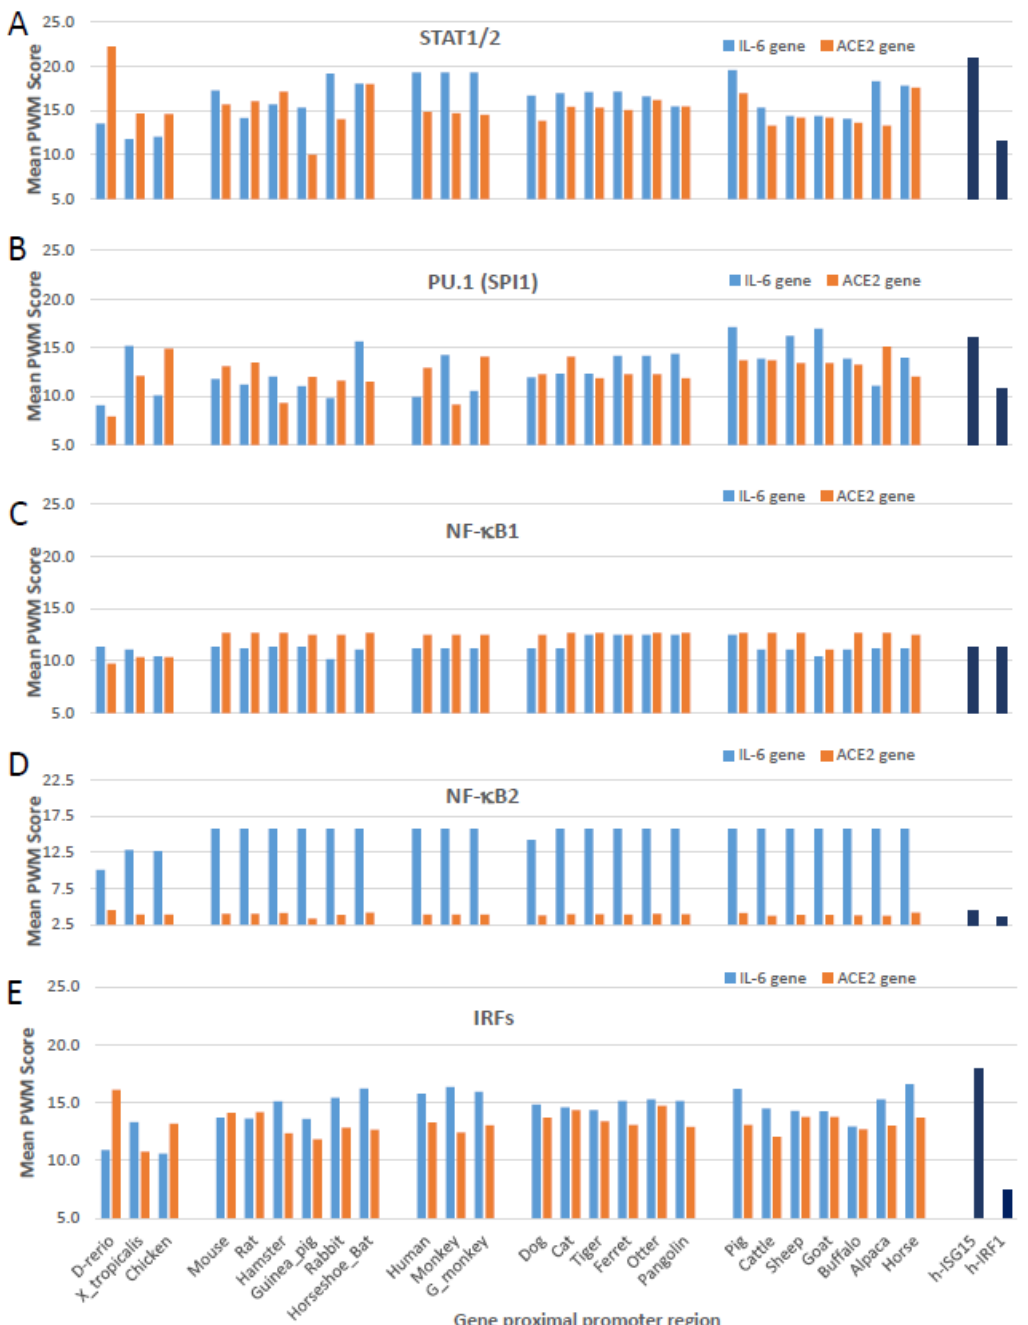
Figure 5. Cross-species analysis of mean PWM scores of cis -regulatory elements (CREs) that bind ( A ) STAT1/2, ( B ) PU.1 (a.k.a. SPI1), ( C ) NF- κB1, ( D ) NF- κB2, and ( E ) IRFs (including IRF1-9, which show significant PWM scores with p < 0.0001)